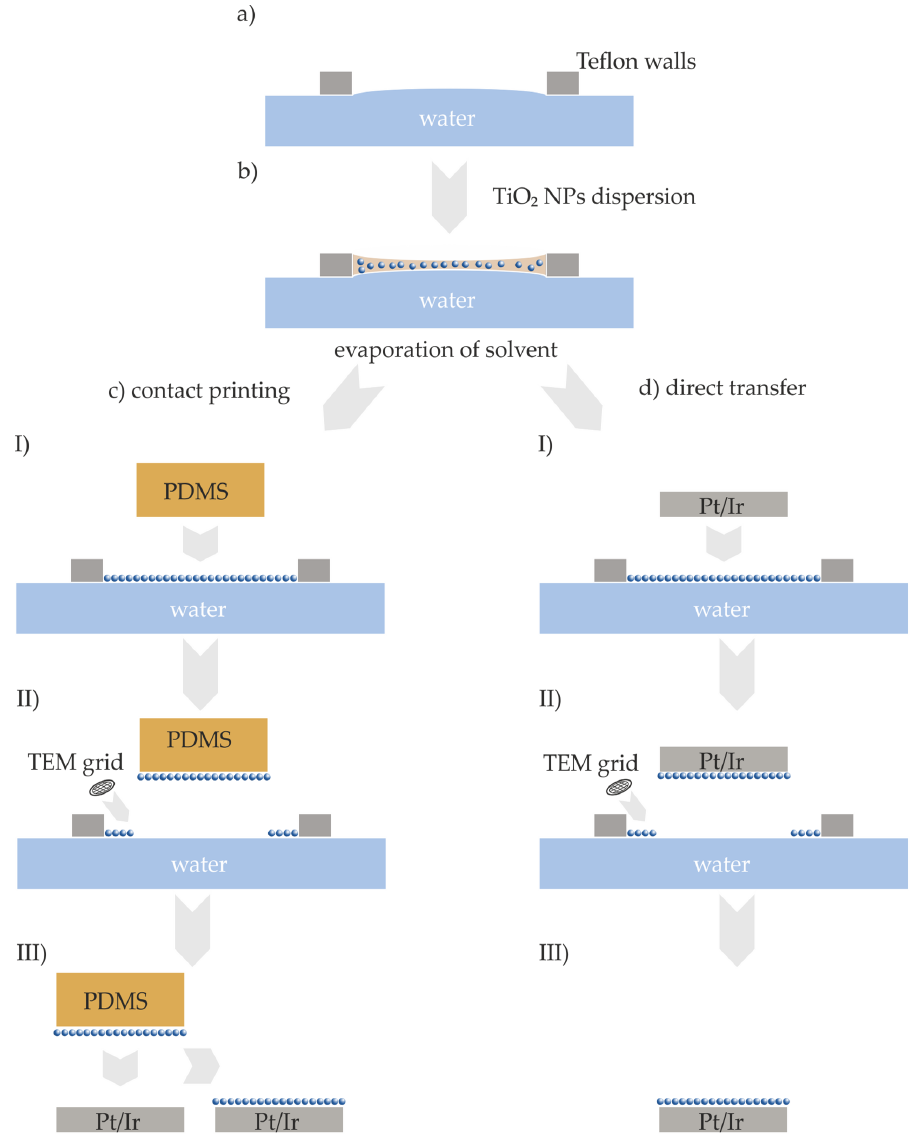
Figure 2. Schematic drawing for the self-assembly of a TiO 2 NP monolayer (not drawn to scale) ( a , b ), for the two-step, microcontact printing method ( c I to III), and for the one-step method for the direct transfer of self-assembled TiO 2 films ( d I to III).